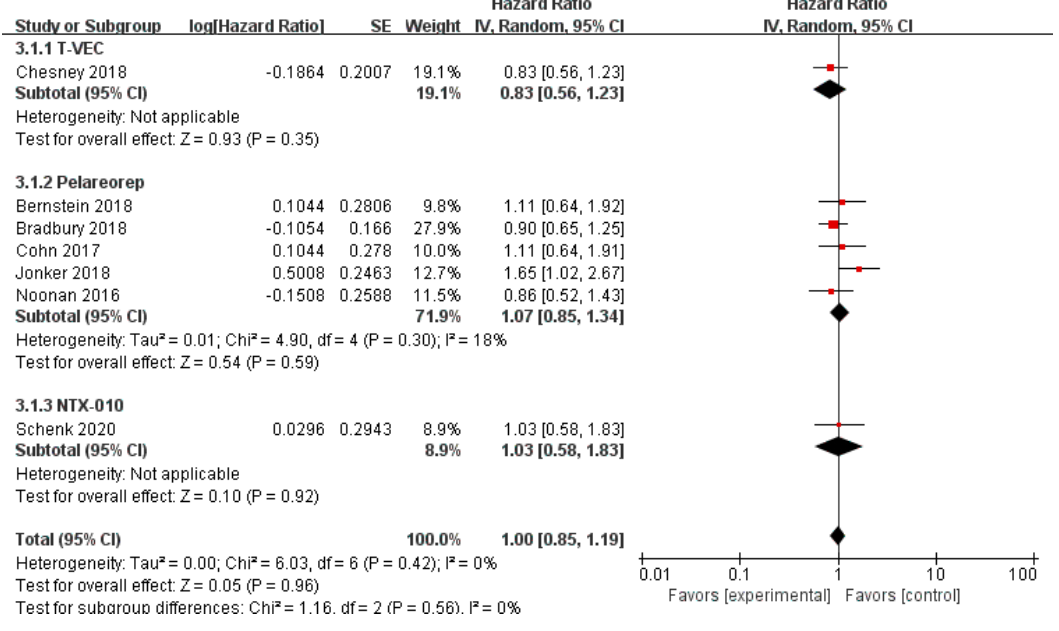
Figure 7. Forest plot of the pooled hazard ratios (HR) for progression-free survival (PFS).